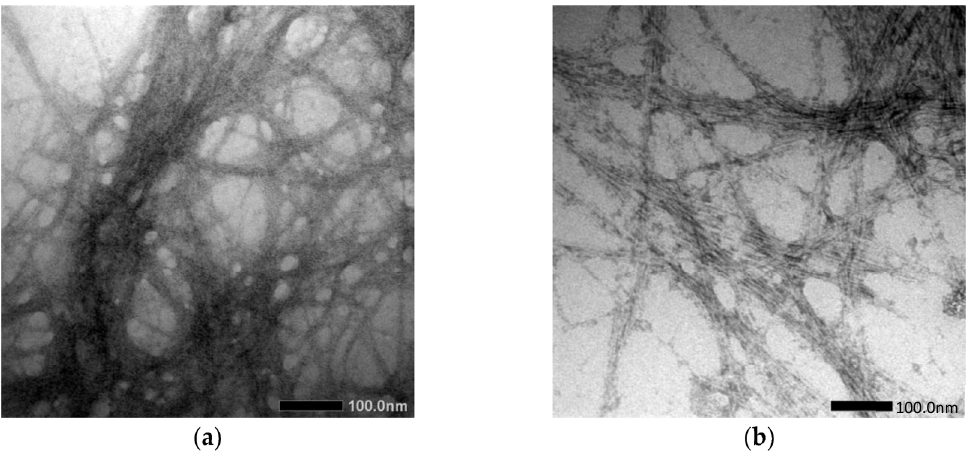
Figure 5. TEM image of ( a ) CNF procedure I and ( b ) CNF procedure II [143].